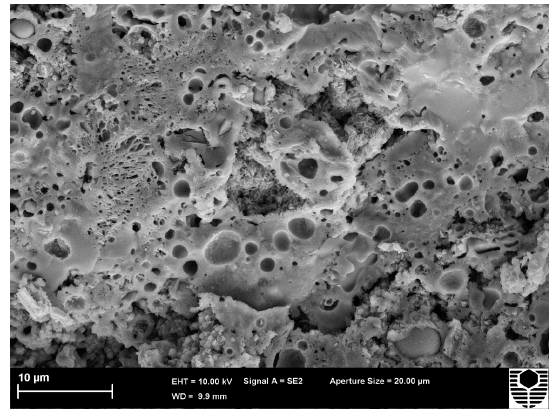
Figure 6. C1.82PP post compression test at 500 °C image.